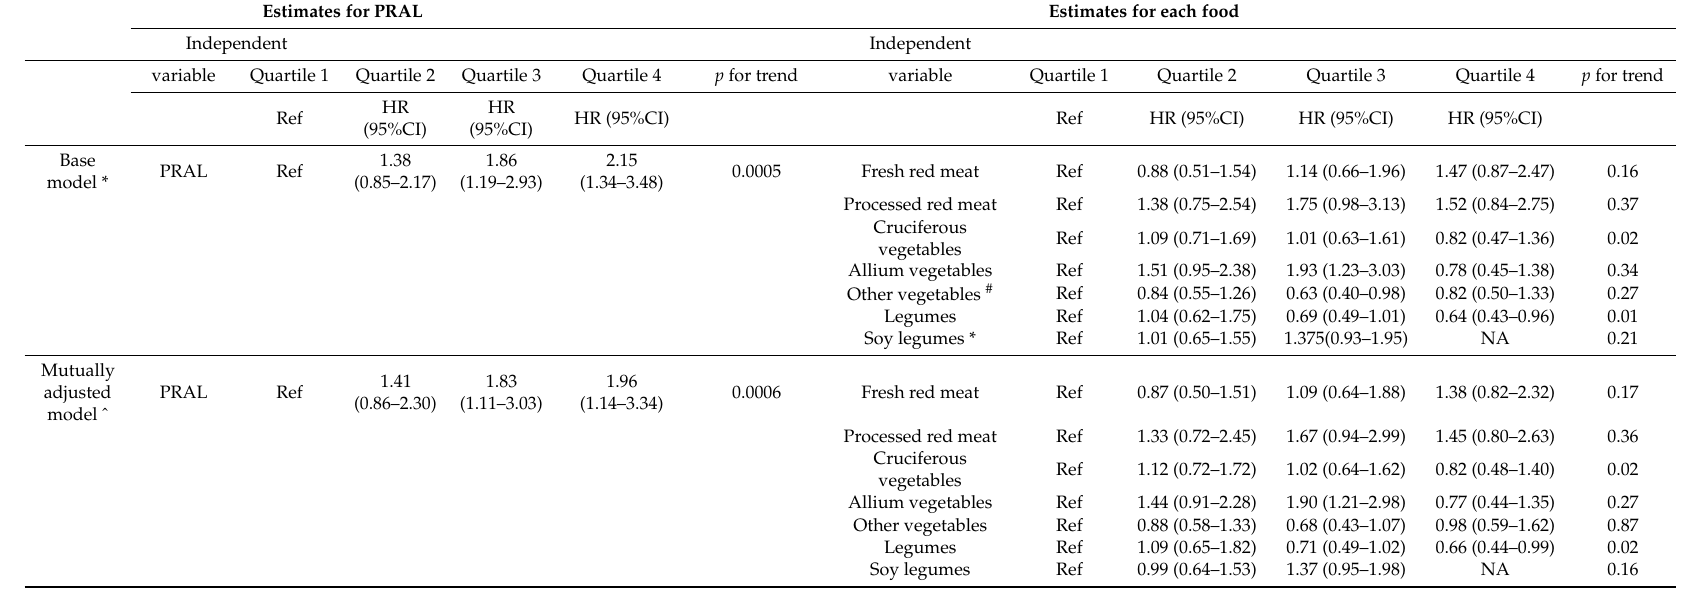
Table A1. The associations of PRAL and PRAL-contributing foods with breast cancer recurrence in stratum with hemoglobin A1c ≥ 5.6%. Estimates for PRAL Estimates for each